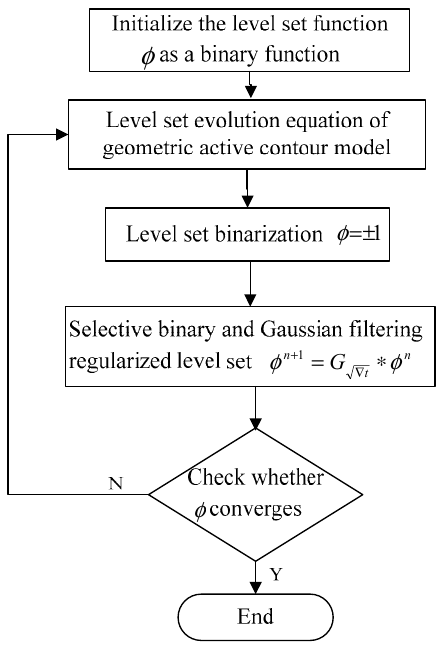
Figure 2. Evolution process of geometric active-contour model. The geometric active-contour model proved in this paper combines the global regional smooth information as the convergence condition of curve evolution, which can effectively solve the influence of speckle noise on the segmentation of the land–sea boundary line in SAR images. The improvement of the symbolic pressure function can solve the problem of weak shoreline boundary. In addition, the SBGFRLS method can obtain faster convergence speed in the process of level-set evolution. In this paper, we use simple grid sampling points to obtain the initial positioning of the shoreline boundary as the initial contour of curve evolution, which can not only reduce the iterative time of the algorithm, but also reduce the possibility of boundary leakage caused by fuzzy boundary to a certain extent, so as to obtain more accurate detection